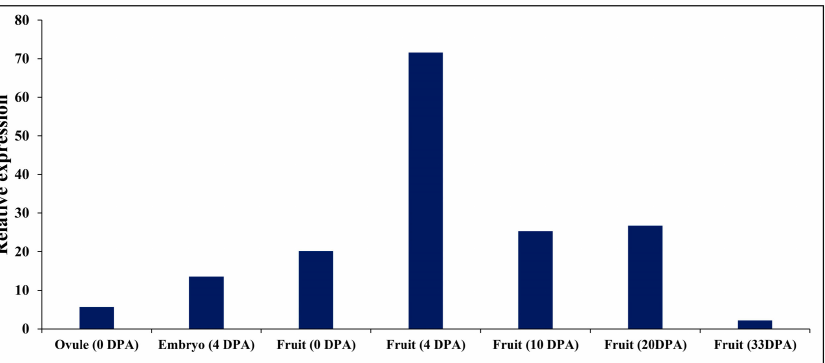
Figure 1. Temporal expression of curl3 gene in WT (wild-type) fruits. The expression profile for curl3 at the different fruit development stages in the WT plants was attained from TFGD (http: //ted.bti.cornell.edu/) on 17 April 2019. DPA, Days post